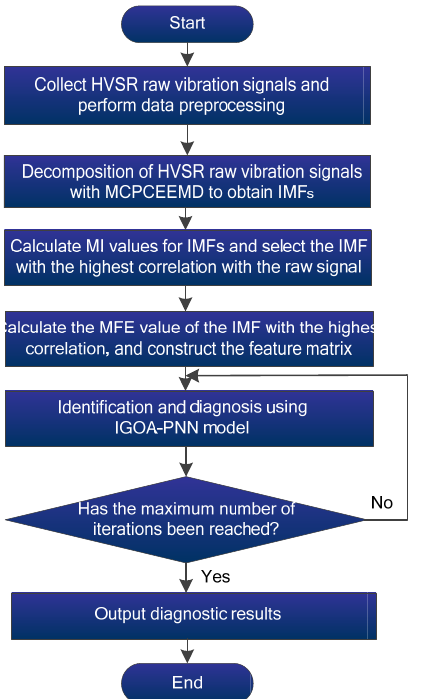
Figure 4. The flow chart of MCPCEEMD-MFE-IGOA-PNN.